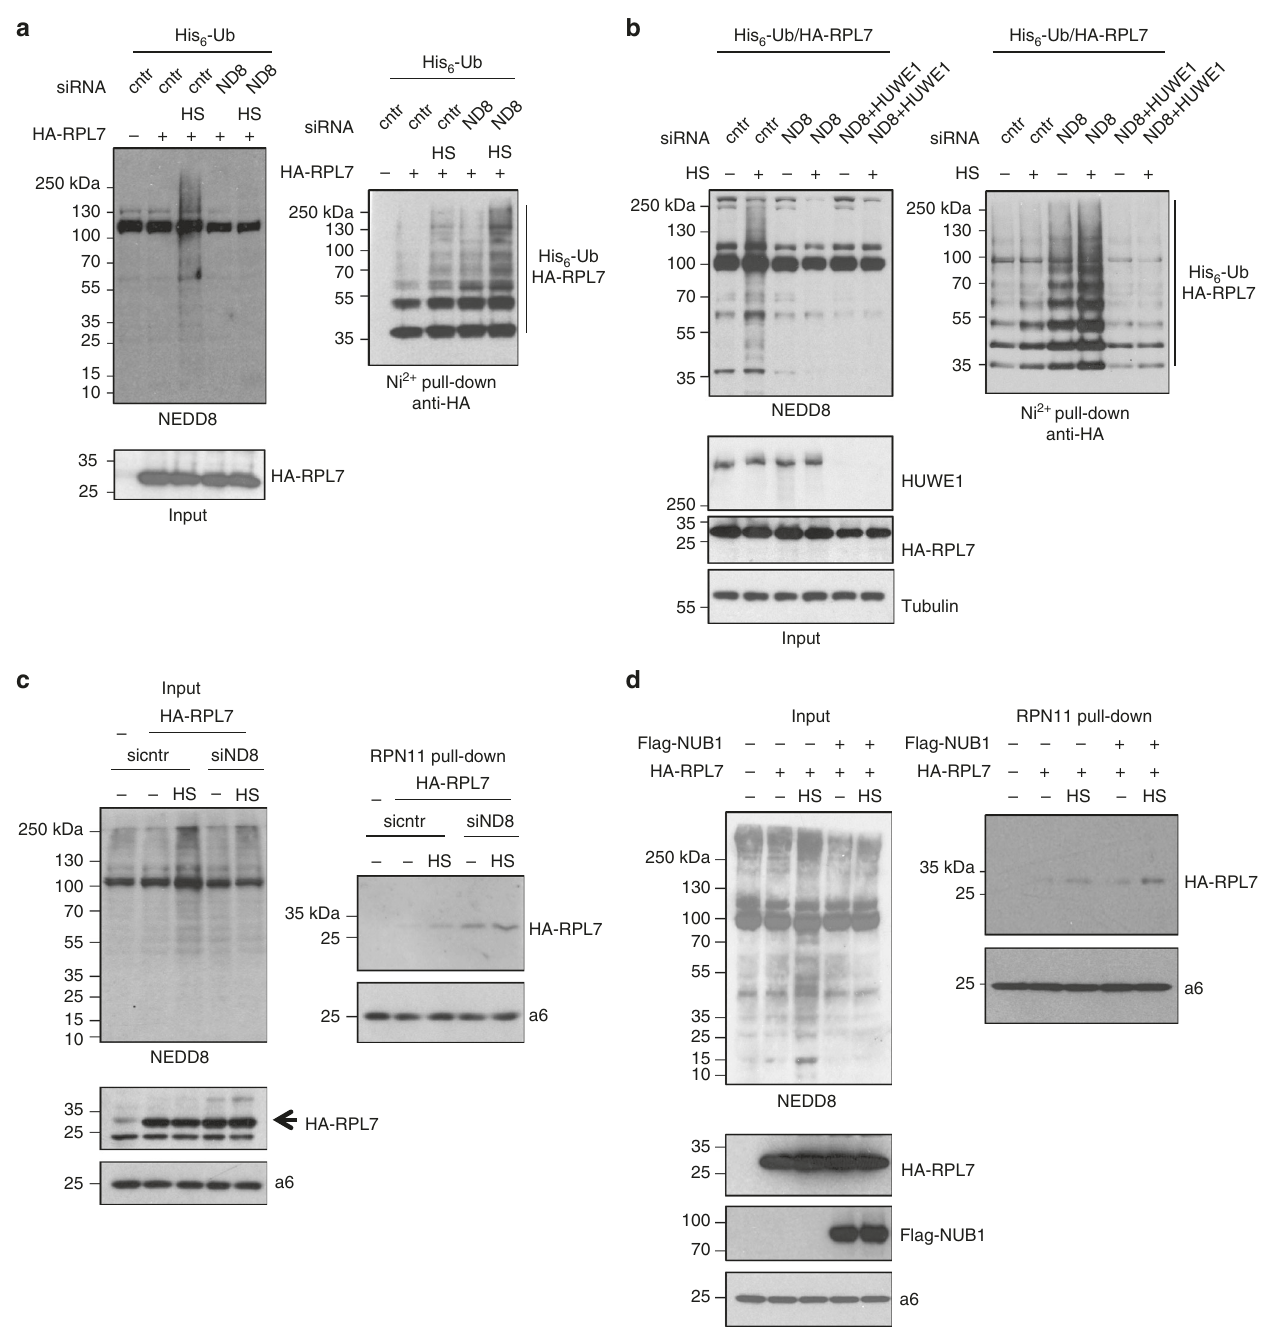
Fig. 8 NEDDylation compromises substrate ubiquitination and targeting to the proteasome. a U2OS cells were fi rst transfected with control or NEDD8 siRNA and 24 h later with His 6 -ubiquitin and HA-RPL7 plasmids as indicated. Twenty-four hours later cells were heat-shocked for 45 min and extracts were used for Ni-NTA pull-downs. Western blotting on puri fi ed His 6 -ubiquitin conjugates and total cell extracts was performed for the indicated proteins. b Similar experiment as in ( a ) but cells were cotransfected with the HUWE1 siRNA as indicated. c HEK293 cells stably expressing RPN11-HTBH were transfected with control or NEDD8 siRNA and 24 h later with RPL7 expressing construct. Twenty-four hours later cells were heat-shocked for 45 min and proteasomes were puri fi ed with streptavidin beads. Total cell extracts or biotin pull-downs were blotted against the indicated proteins. d Similar experiment as in ( c ) with the exception that Flag-NUB1 or pcDNA3 (5 μ g) constructs were transfected